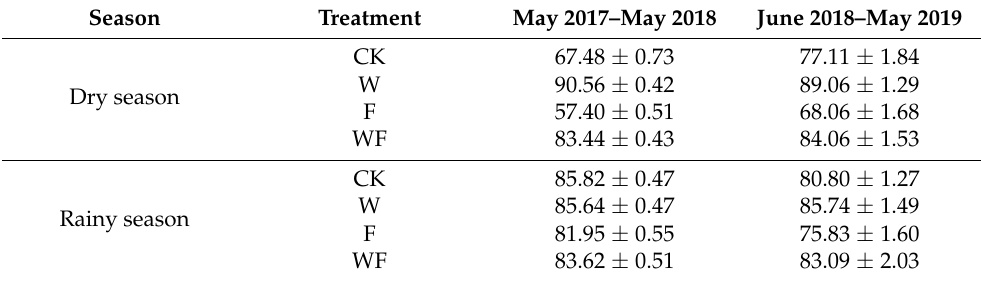
Table 1. The relative soil water content (%) from April 2017 to May 2019, before